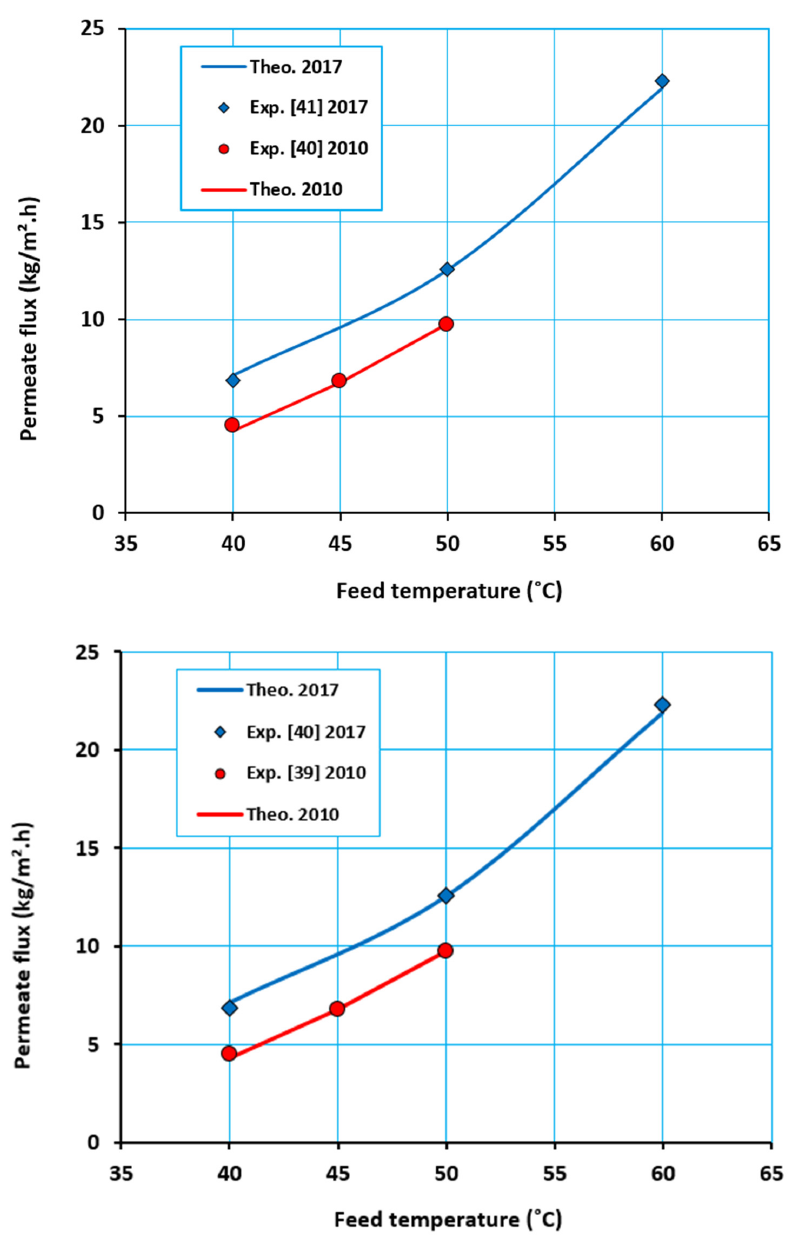
Figure 14. Present model results simulating the experimental data of other studies